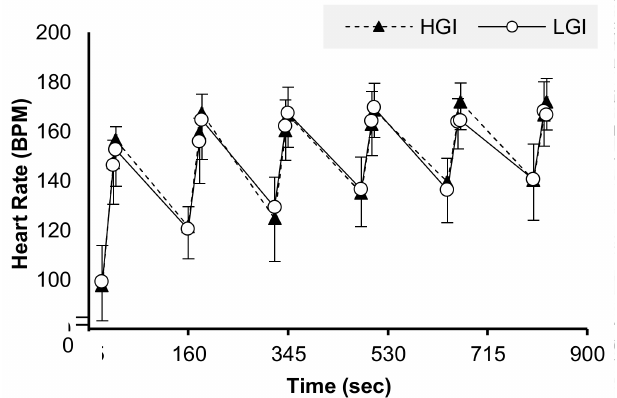
Figure 2. Heart rate during the evening SIT exercise in the HGI and LGI